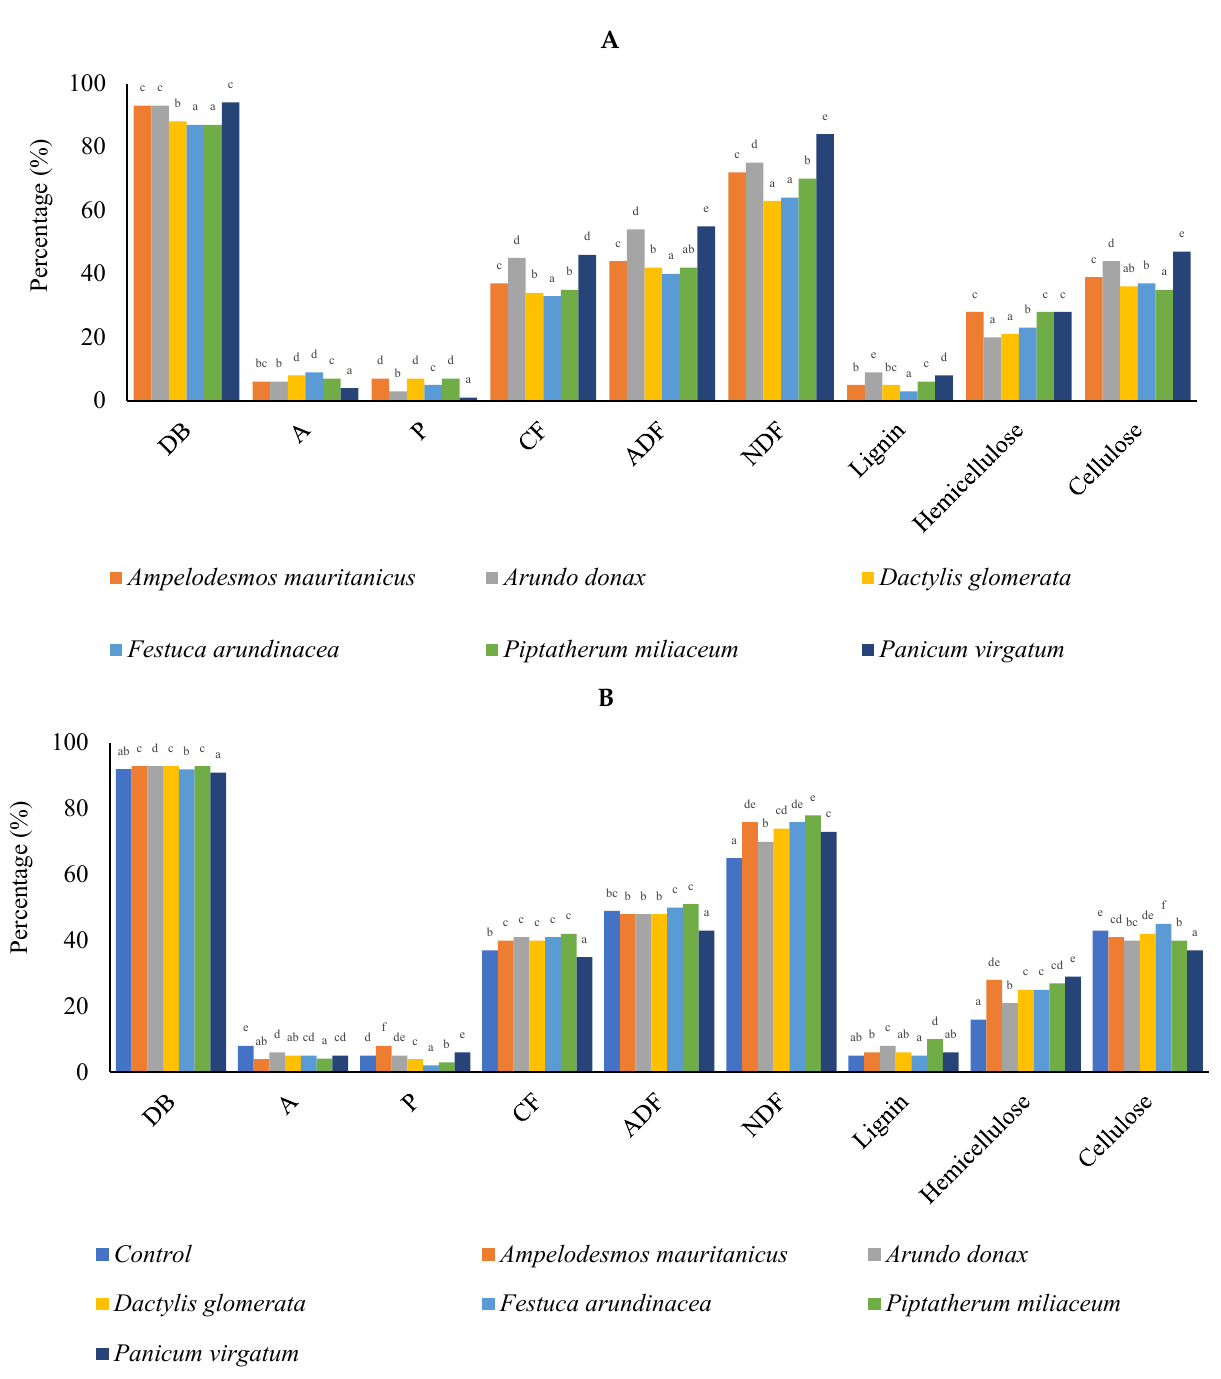
Figure 3. Bromatology results of the two cuts (2014—( A ) and 2016—( B )) analyzed. (DB: dry biomass; A: ash; CF: crude; ADF: acid detergent fiber; NDF: neutral detergent fiber; P: protein). Different letters indicate significant differences between species or growing cycle.